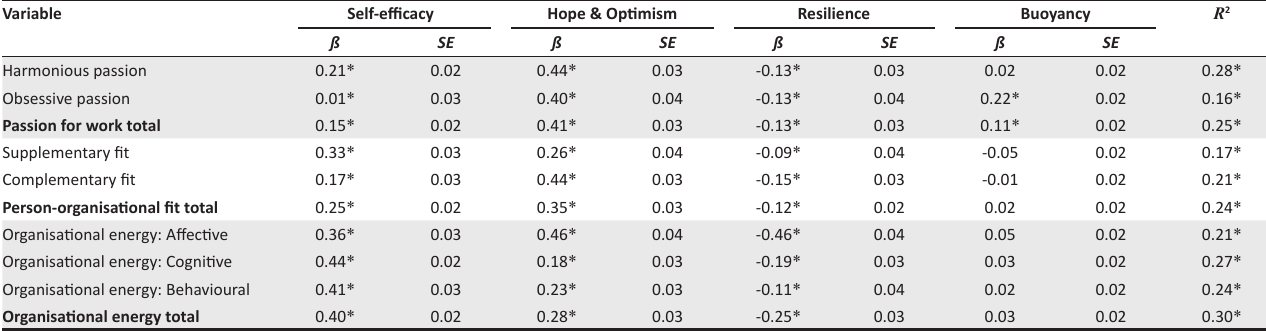
TABLE 14: Discriminant validity of the adapted (reconfigured) Psychological Capital Questionnaire factors. Variable